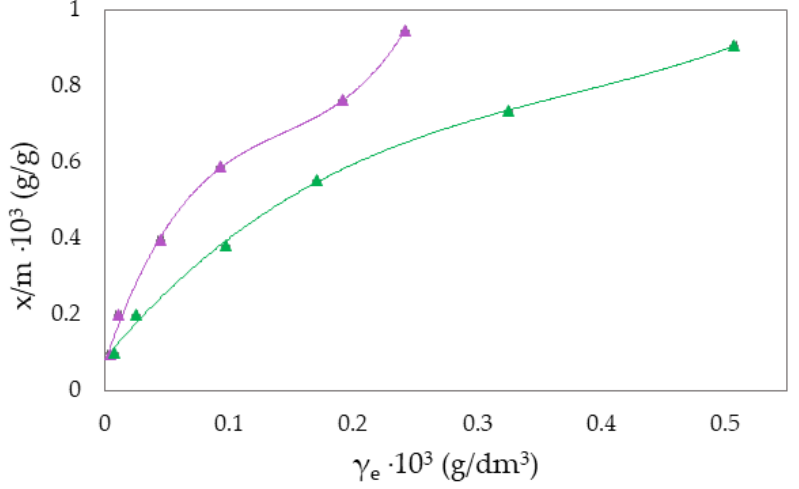
Figure 2. Freundlich adsorption isotherm curves for the suspension RB-NH 4 ZSM-5 at ▲ 283 K and ▲ 293 K.